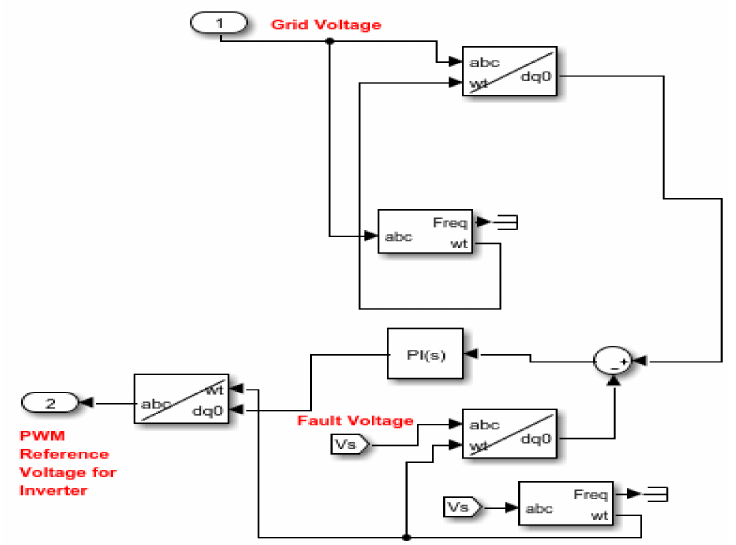
Figure 10. Voltage tracking